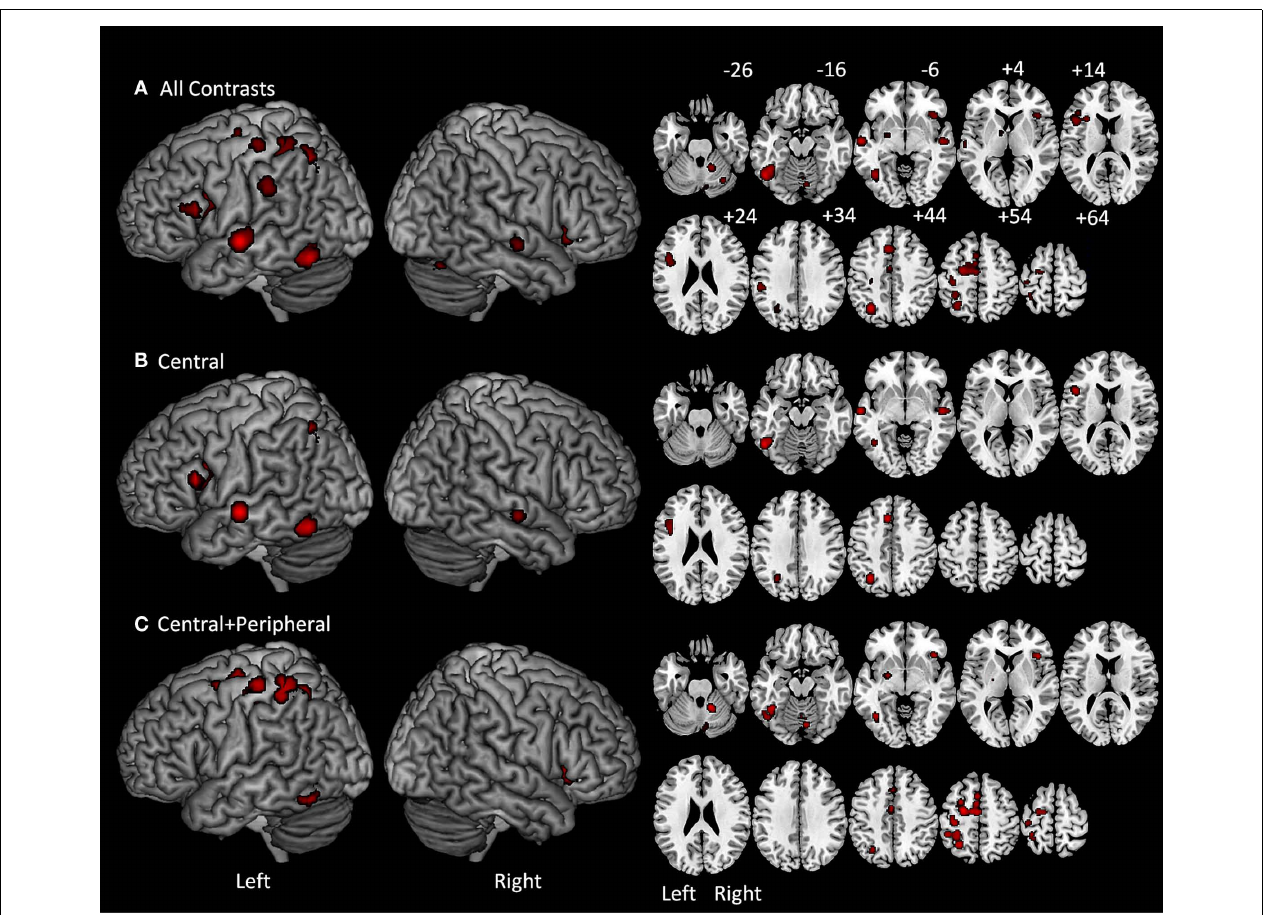
Central-contrasts meta-analysis included only the tasks that involved central, but not peripheral written production processes. (C) Central + peripheral contrast meta-analysis included all of the tasks that involved both central and peripheral written production